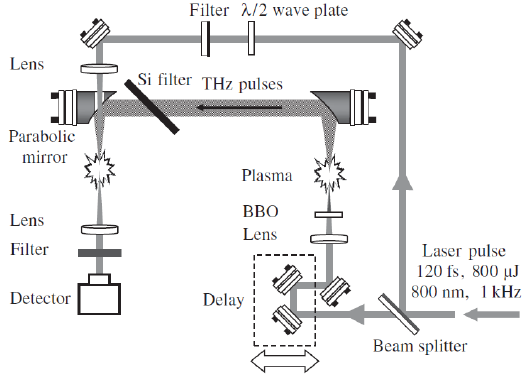
Figure 9. Schematic diagram of the coherent detection of broadband THz waves with ambient air [62].